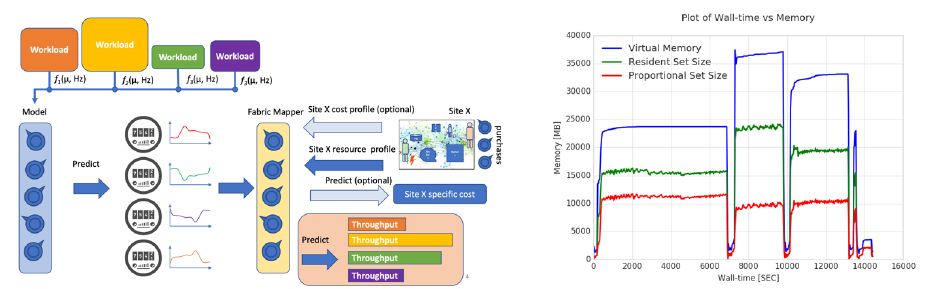
Figure 1. (left) Workload resource requirements depend on the pile-up and the trigger rate. The model predicts the demands on the di ff erent resources. The Fabric Mapper abstracts the characteristics of a fabric and produces estimates for throughputs. Optional sites can add their local cost structure to the model. (right) Memory consumption over the execution of an ATLAS Digi-Reco job from PrMon; the di ff erent processing steps are clearly visible. The periods with very low memory consumption are due to the merging of intermediate